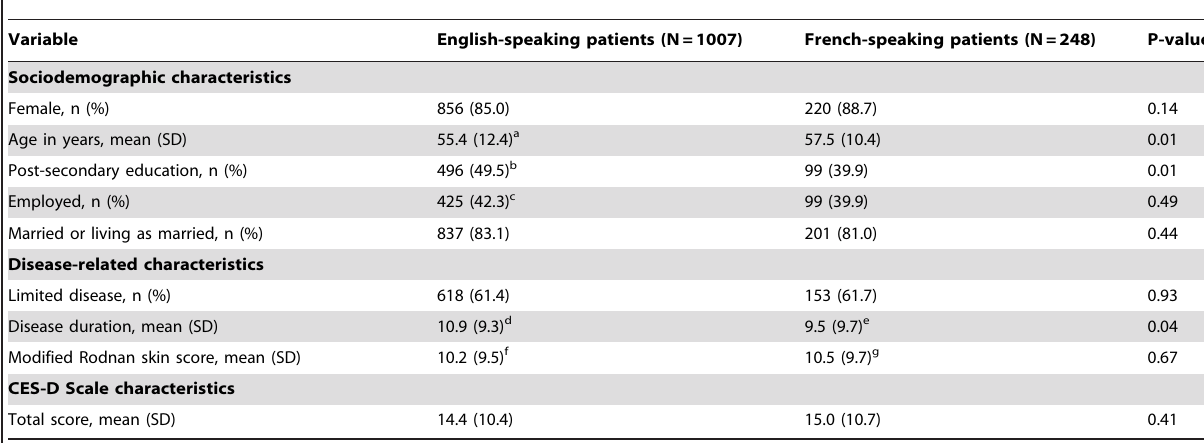
Table 1. Sociodemographic and Disease-Related